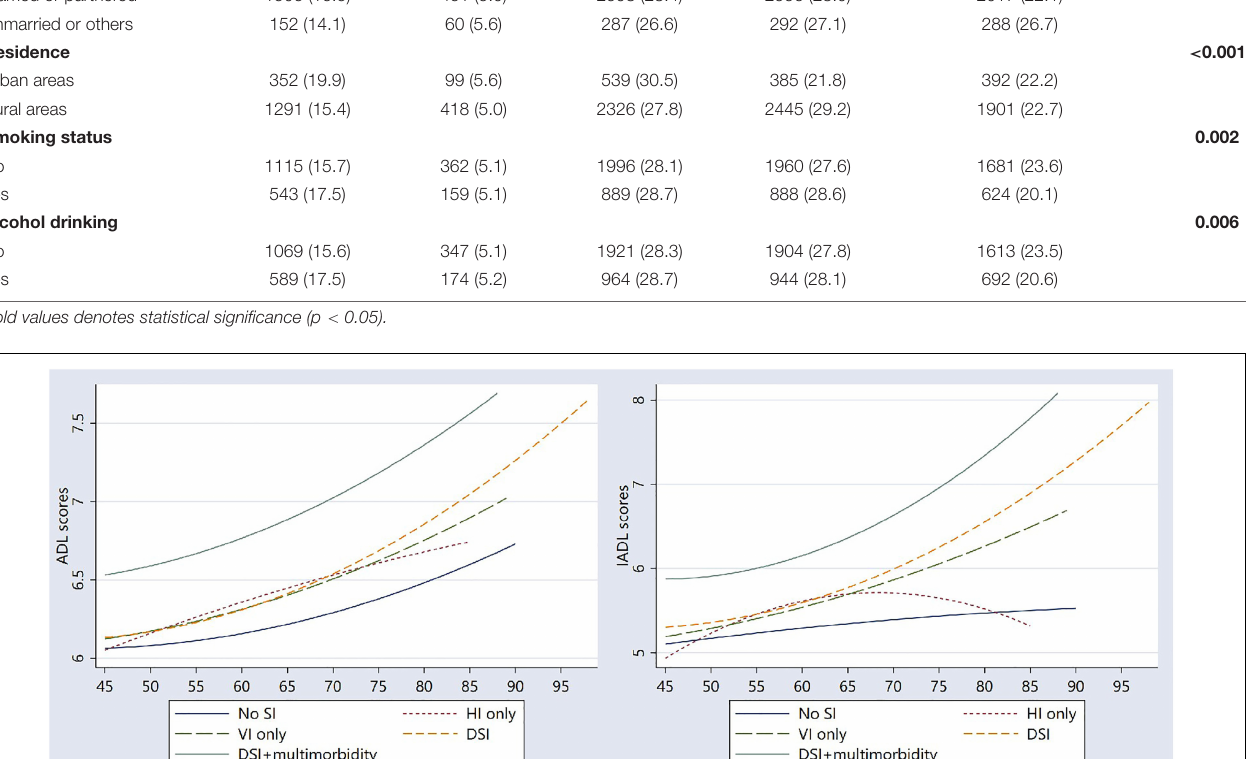
models for the longitudinal relationships between subsequent at baseline. The analysis was restricted to those with DSI. After of DSI and multimorbidity patterns presented statistically significant associations with ADL limitations compared with